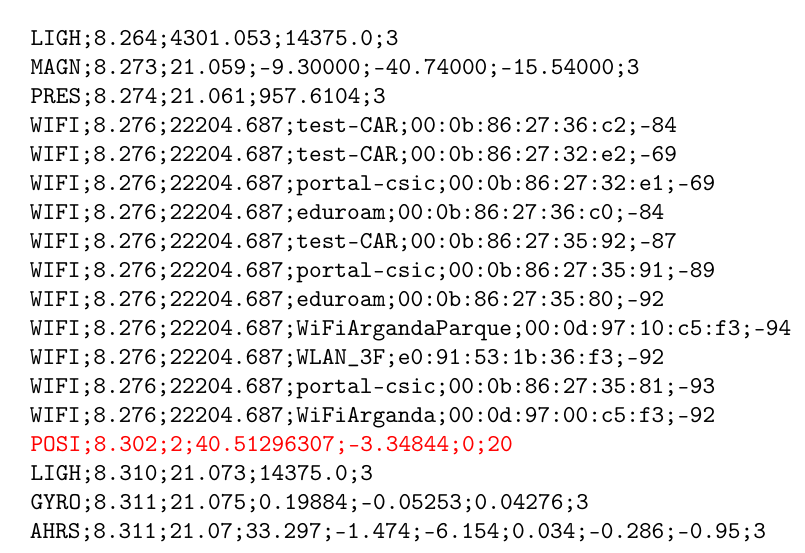
Figure 2. An excerpt from a logfile, as provided to the competitors. Note that the example includes a POSI entry (ground truth location highlighted in red color in the excerpt), but these entries are not included in the evaluation files since they do not contain ground truth locations.